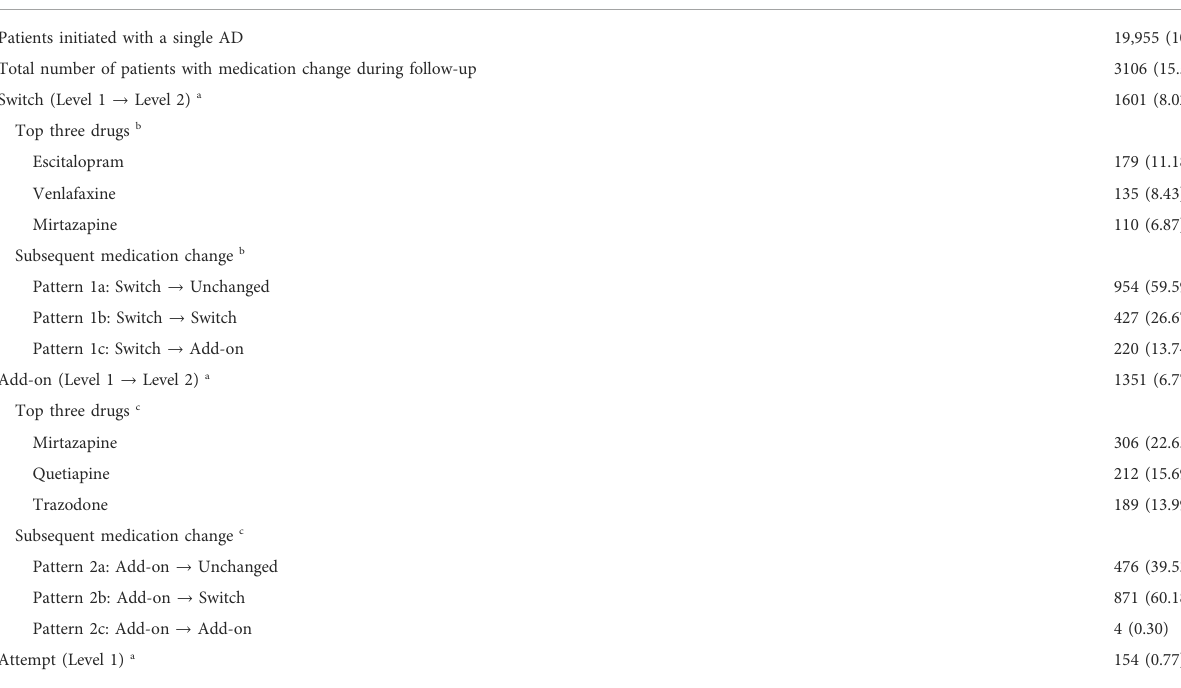
TABLE 4 Medication changes on the fi rst three levels of patients initiated single